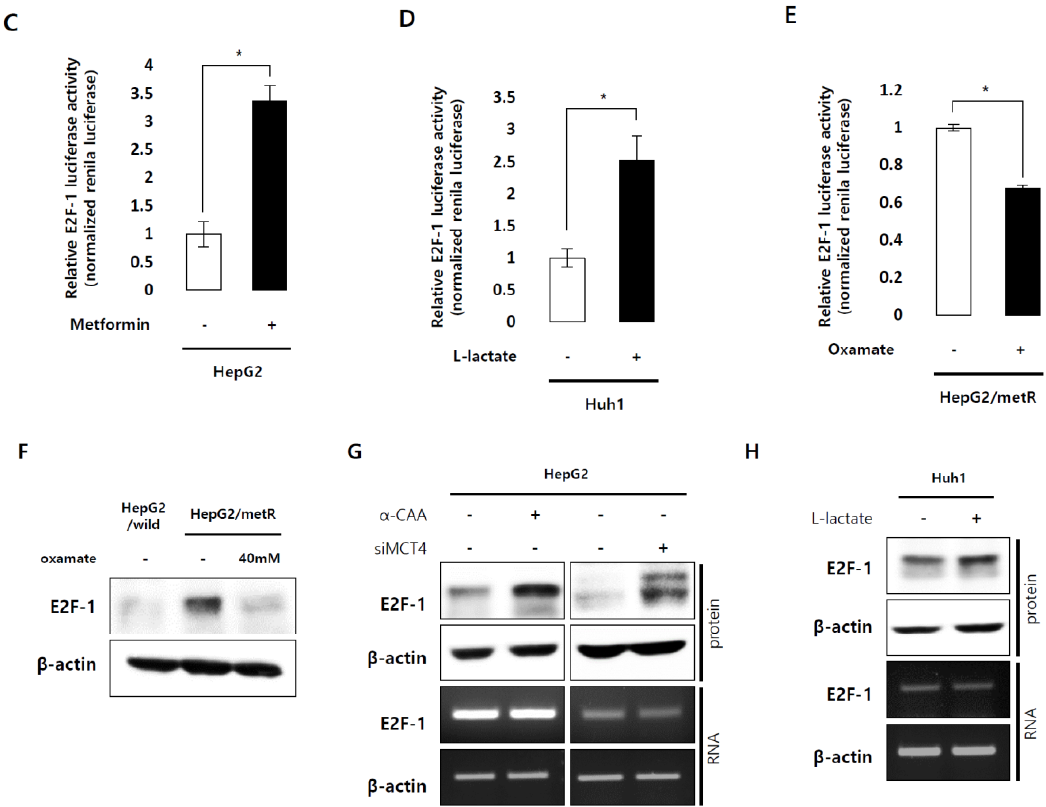
Figure 3. Role of E2F1 pathway in lactate-induced gene expression and its regulation by lactate. ( A ) Profiling of upstream regulators of lactate-induced gene expression. Transcriptome data for HepG2/metR cells with or without oxamate treatment were subject to a sub-network enrichment analysis using Pathway Studio program, and the activation score (Z-score) of putative upstream regulators was quantitatively estimated. Dotted lines represent a statistical significance of p < 0.05 in both directions. ( B ) Upstream regulators predicted for the eleven lactate-responsive genes related to ‘microtubule functions’ through the literature mining process of Pathway Studio. ( C – E ). Lactate-dependent transcription activity of E2F1 was measured by E2F1-driven luciferase reporter assays in ( C ) metformin (10 mM)-treated HepG2 cells, ( D ) exogenous L -lactate (50 mM)-treated Huh1 cells, and ( E ) oxamate (40 mM)-treated HepG2/metR cells. The luciferase activity values were normalized by renilla luciferase values. All results from three independent experiments are shown as mean ± SD. The p -value was assessed by Student’s t -test. * p < 0.05 and ** p < 0.01 vs. control. ( F – H ). The protein and mRNA expression of E2F1 gene in various lactate-enriched microenvironments including ( F ) oxamate (40 mM)-treated HepG2/metR cells, ( G ) pharmacological inhibition of lactate transporter or siRNA-mediated depletion of MCT4 in HepG2 cells, and ( H ) exogenous L -lactate treatment in Huh1 cells.